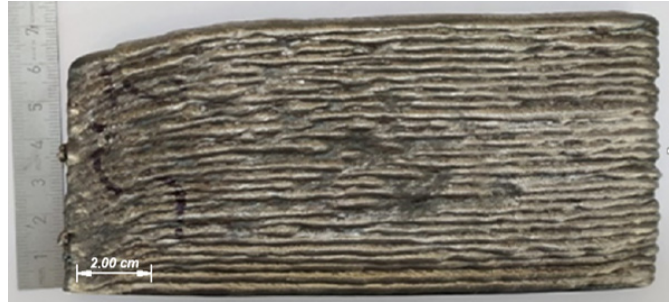
Figure 11. The wall appearance, mode I = 120 A, U = 20 V.